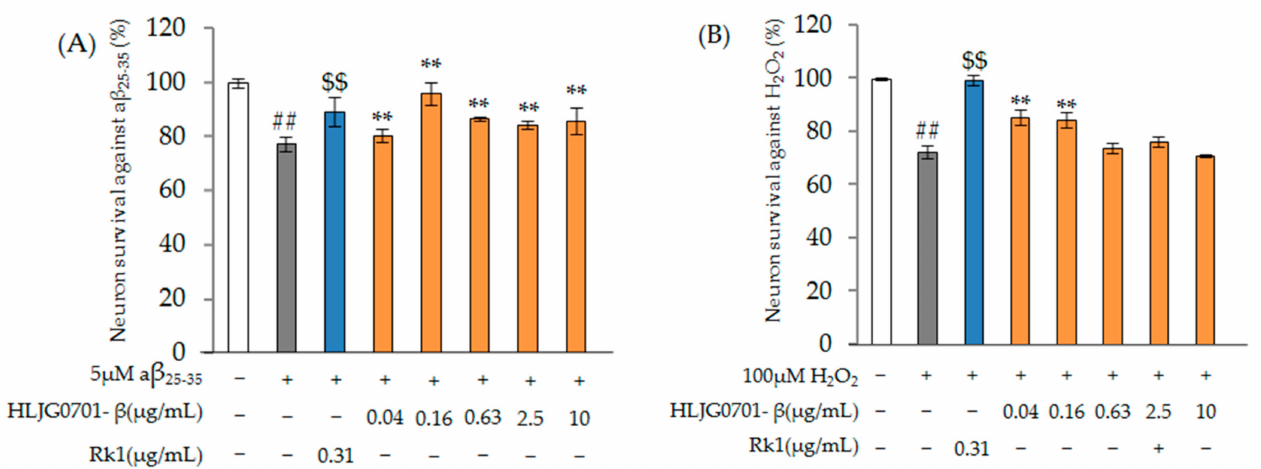
Figure 3. Neuroprotective effects against ( A ) amyloid- β 25-35 and ( B ) H 2 O 2 induced damage. Data are presented as mean ± standard deviation. Error bar: standard deviation; ##, significant difference compared with control by Student’s t -test, p < 0.01; $$, significant difference compared with negative control by Student’s t -test, p < 0.01; **, significant difference compared with negative control by one-way ANOVA, p <